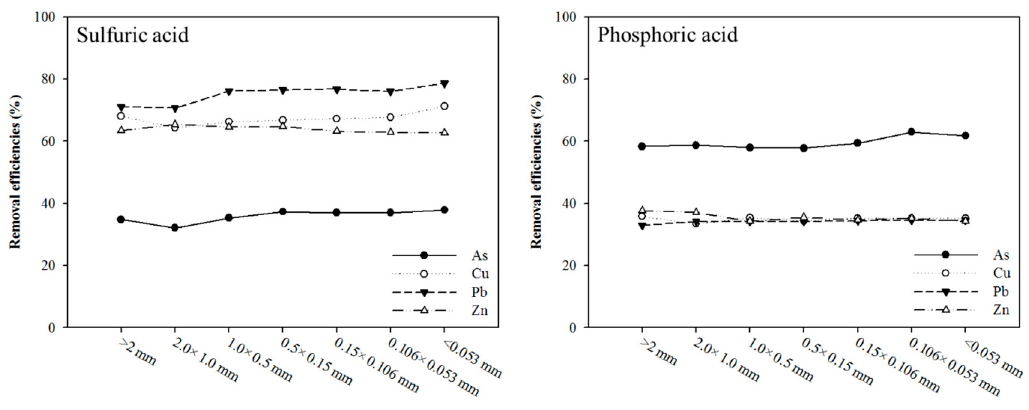
Figure 6. Effect of size fraction on the extraction of As, Cu, Pb, and Zn from the batch test with 0.6 M sulfuric acid and 0.6 M phosphoric acid.